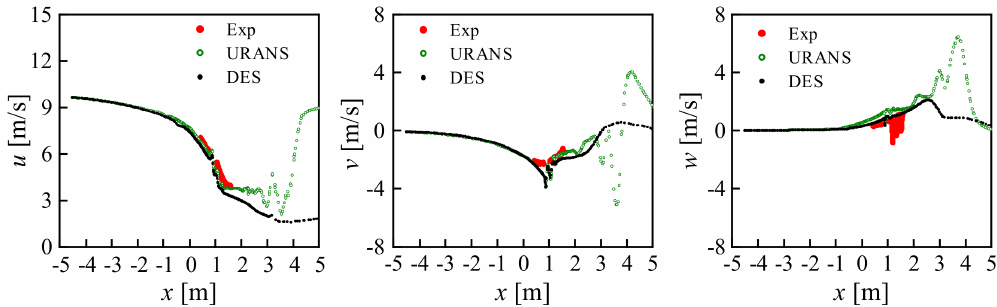
Figure 24. Axial profile of velocity components at y = − 1.5 m under wind speed of 10 m/s, TSR = 10.